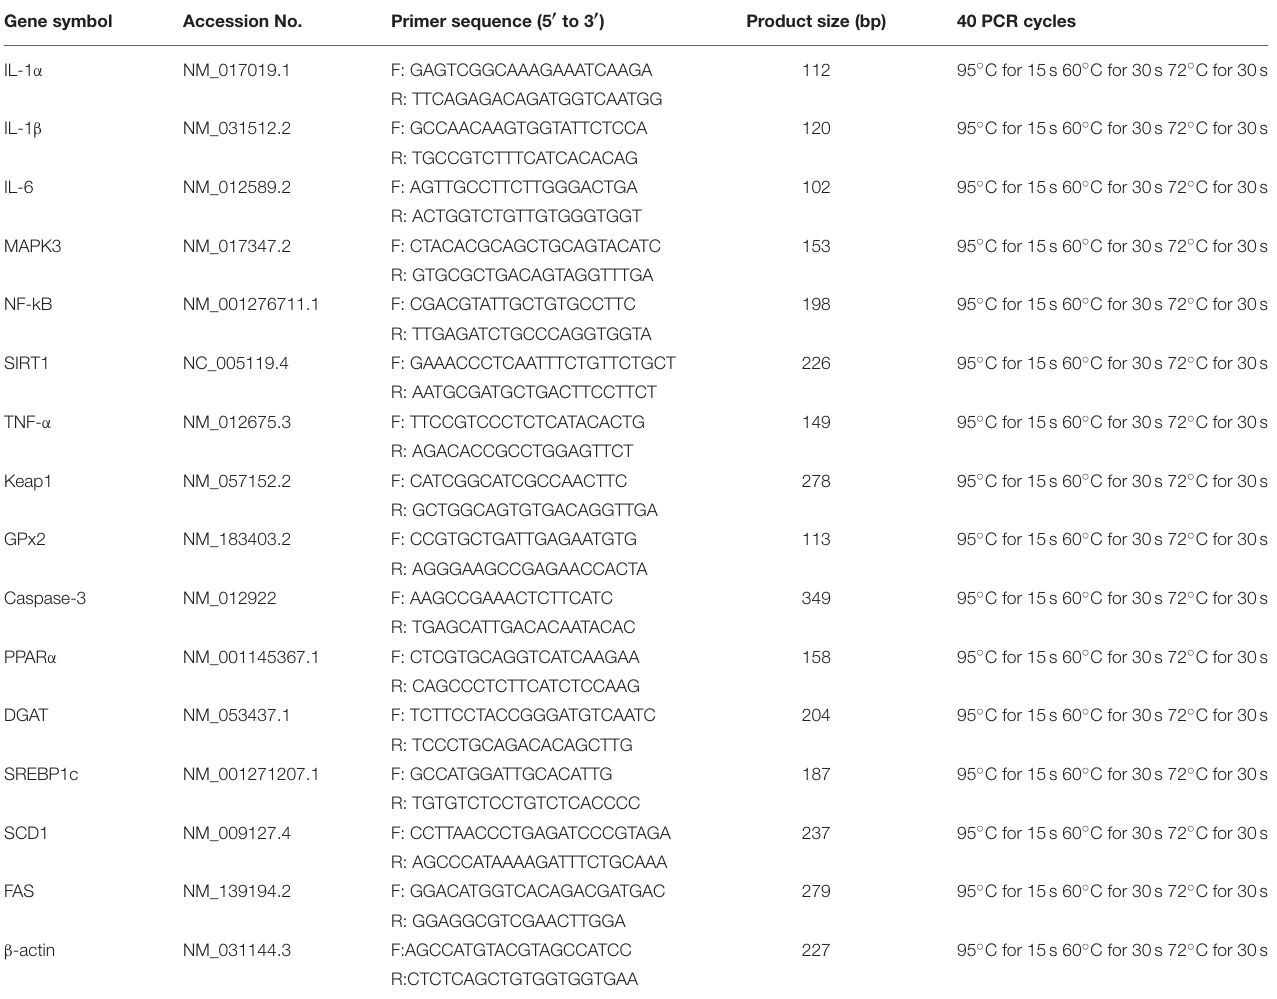
TABLE 1 | Primers used for quantitative real-time PCR. Gene symbol Accession No. Primer sequence (5 ′ to 3 ′